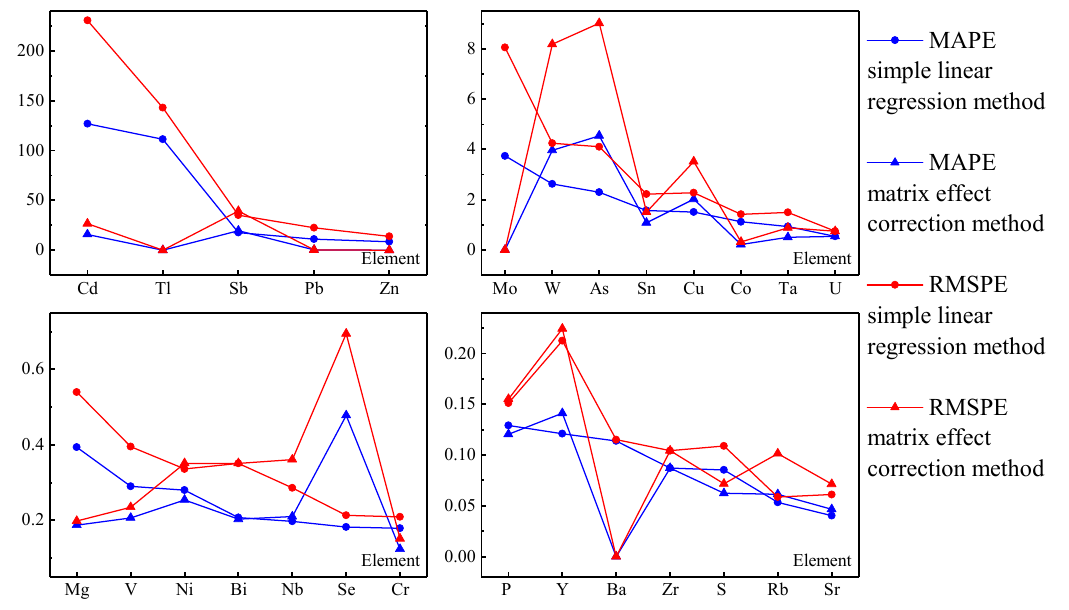
Figure 4. The MAPE and RMSPE values for the correction results of the new and SLR methods.